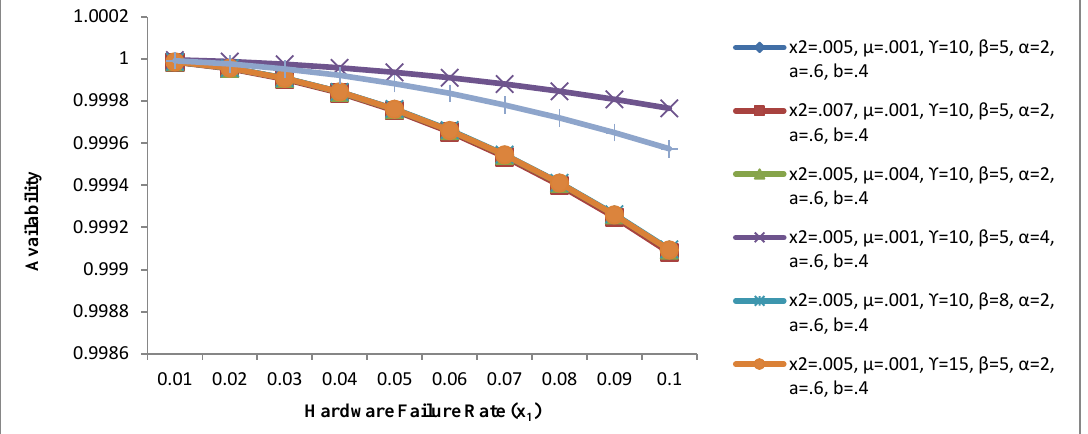
Figure 3. Availability vs hardware failure rate ( 𝑥